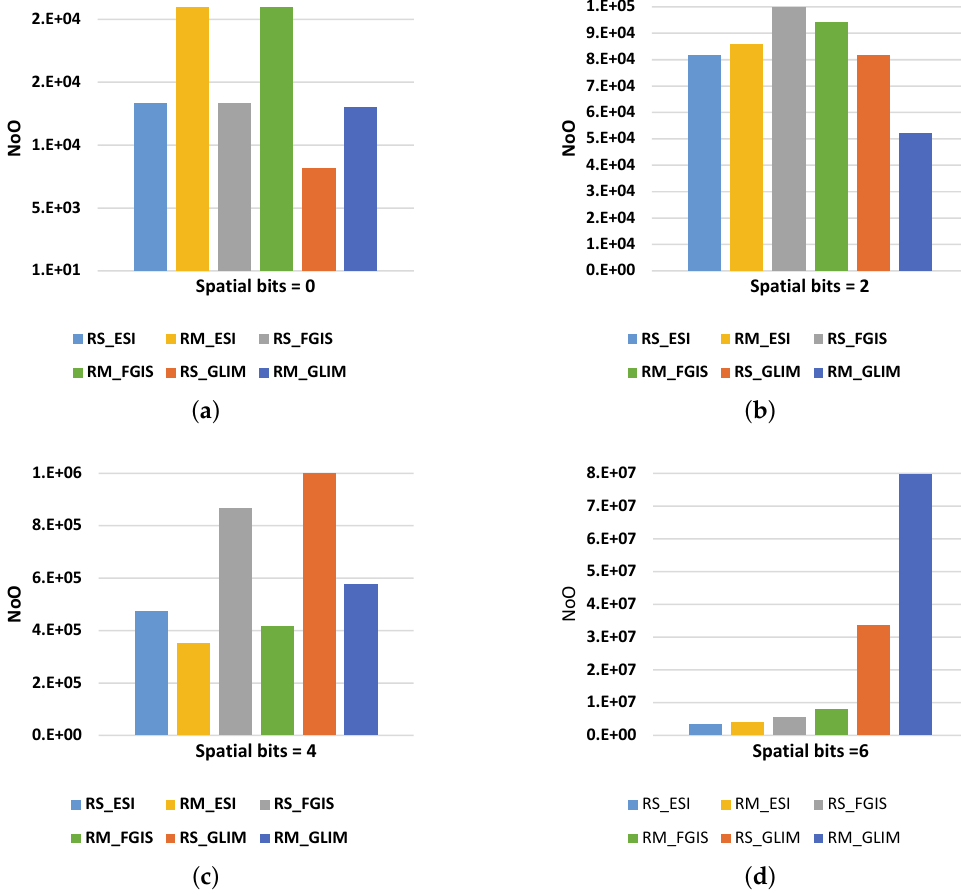
Figure 7. Computational complexity of the proposed ESI compared with the CC of the FGIS [33] and the GLIM [31] at different achievable data rates: ( a ) log 2 ( M ) (zero spatial bits); ( b ) log 2 ( M ) + 2 (two spatial bits); ( c ) log 2 ( M ) + 4 (four spatial bits) and ( d ) log 2 ( M ) + 6 (six spatial